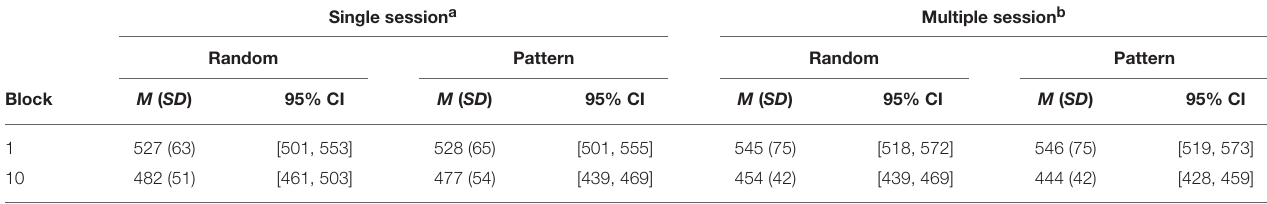
TABLE 4 | Descriptives for ASRT Reaction time for factors session, trial type, and block (1, 10). Single session a Random Pattern Random Pattern